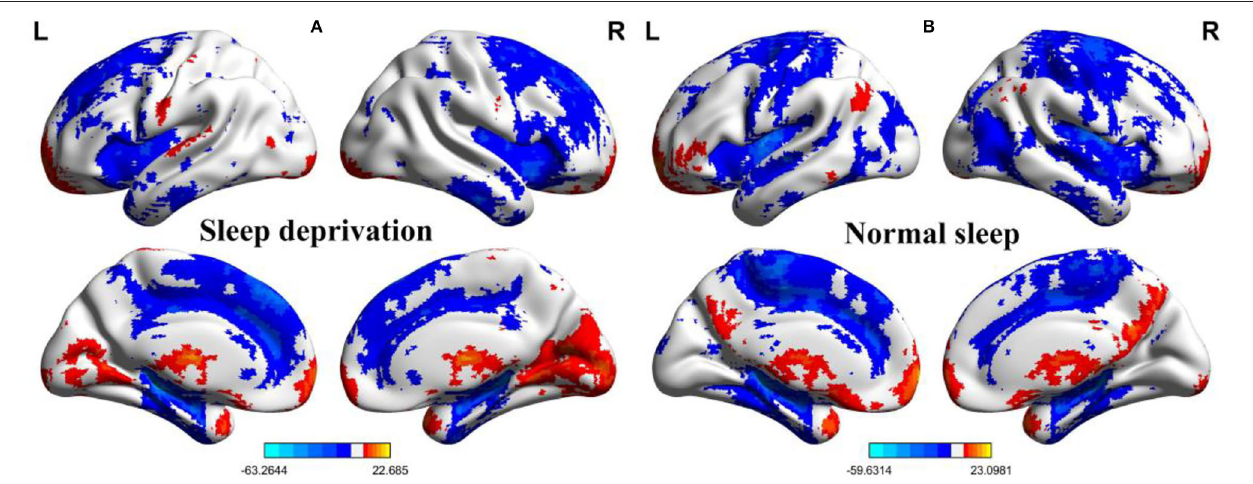
FIGURE 1 | One sample t -test differences of SD status and normal sleep status in PerAF maps. (A) One sample results for sleep deprivation group; (B) One sample results for normal sleep group. SD, sleep deprivation; R, right; L, left; PerAF, percent amplitude of fluctuation.